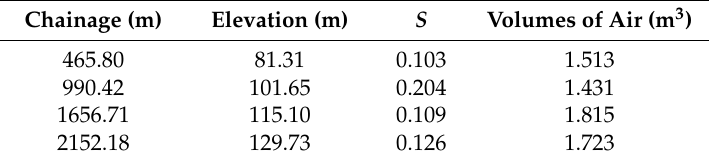
Table 2. Air pocket volumes and their location when 4 pumps perform at the pumping